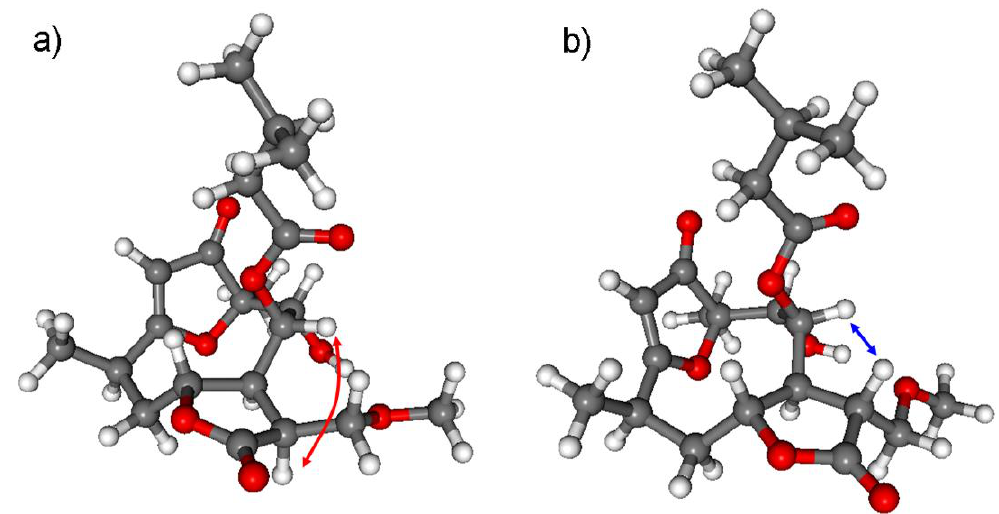
Figure 4. The characteristic H-8–H-11 NOE correlation indicated on the lowest-energy conformers of the ( a ) (4 R ,6 R ,7 S ,8 S ,9 R ,10 R ,11 S )- 2 (3.50 Å) and ( b ) (4 R ,6 R ,7 S ,8 S ,9 R ,10 R ,11 R )- 2 (2.19 Å) stereoisomers. Level of optimization: B3LYP/6-31+G(d,p).